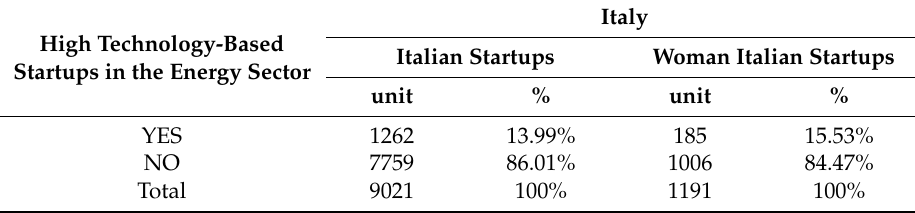
Table 12. Italian startups and Italian woman startups operating in the high technology energy sector.